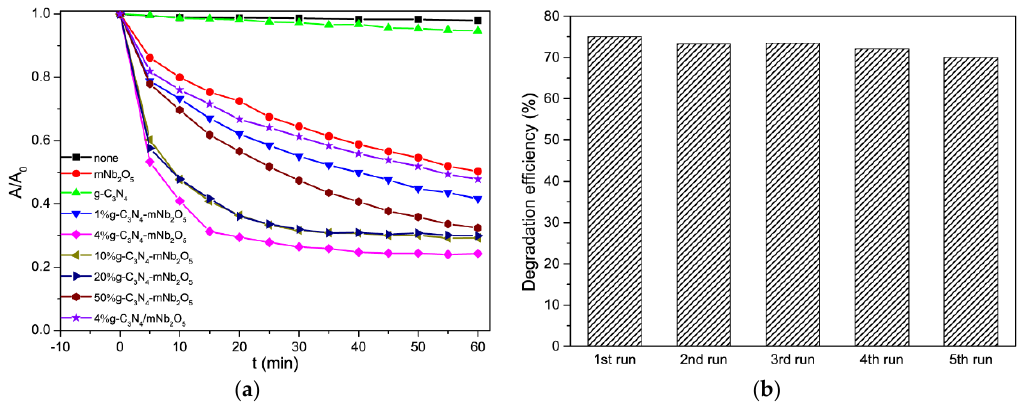
Figure 9. ( a ) Photolysis of TC-HCl and photocatalytic activity over as-prepared photocatalysts for TC-HCl; and ( b ) recyclability for the photodegradation of TC-HCl in the presence of 4% g-C 3 N 4 -mNb 2 O 5 under visible light irradiation.